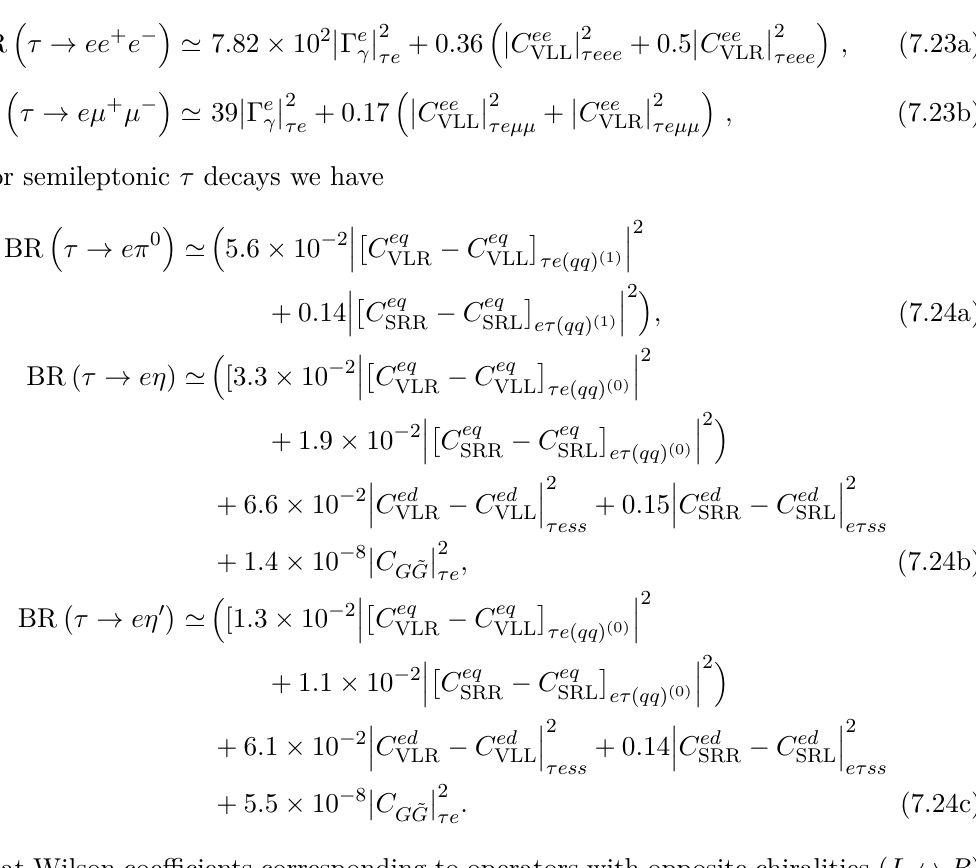
and c , in table 11 are eϕ Lϕ